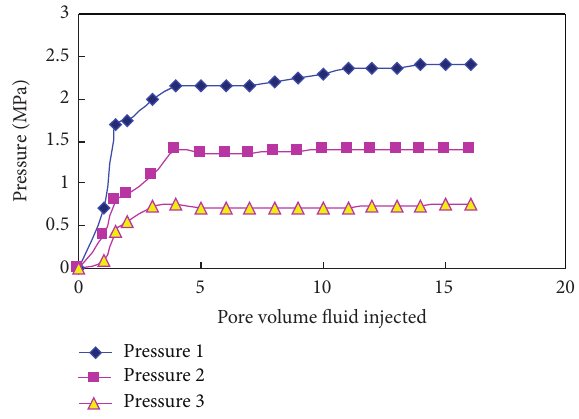
Figure 7: Conductivity of the HAPAM ASP flooding system in porous